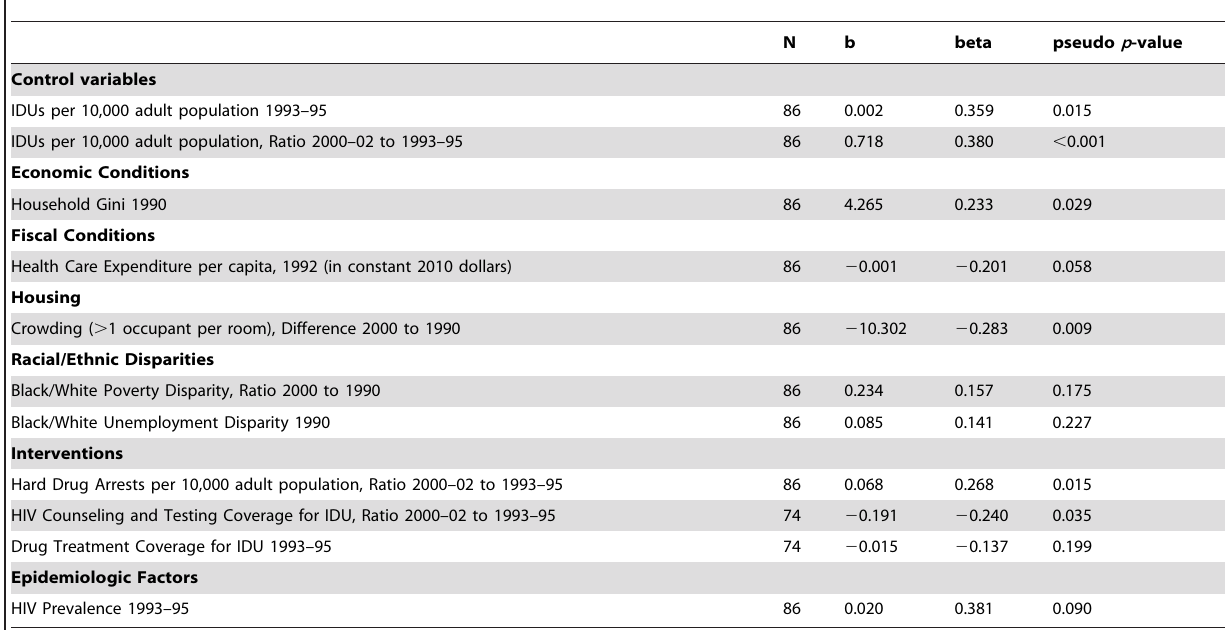
Table 3. Regression results for domain analyses of variables predicting decline in log mortality rates of IDUs living with AIDS per 10,000 adult population (ages 15–64) - Based on best AIC score within